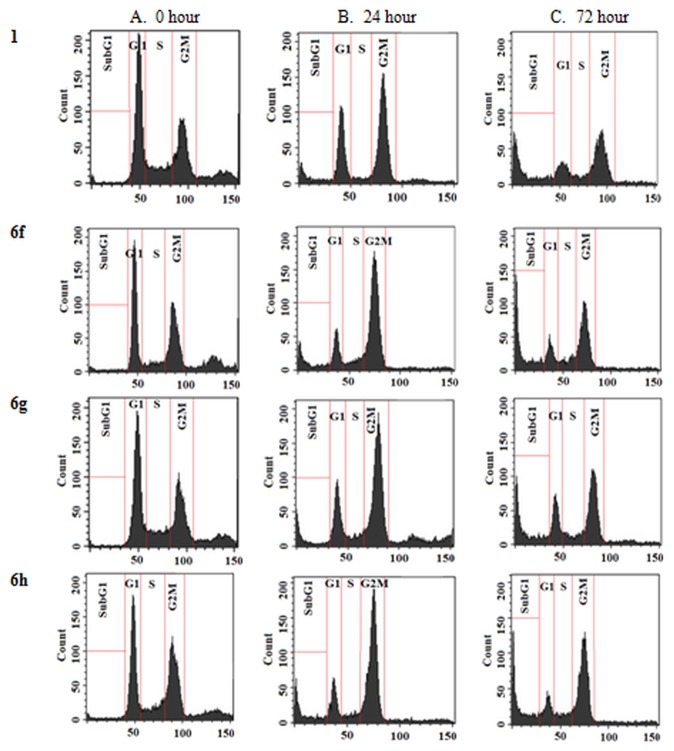
Noscapine (1) and its analogues 6f-h inhibit cell cycle progression at mitosis followed by the appearance of a characteristic hypodiploid (sub-G1) DNA peak, indicative of apoptosis.Panels A-C depict analyses of cell cycle distribution in a two-dimensional disposition as determined by flow cytometry in MCF-7 cells treated with 25 µM of noscapine (1), 6f, 6g, and 6h for 0, 24 and 72 hours, respectively.